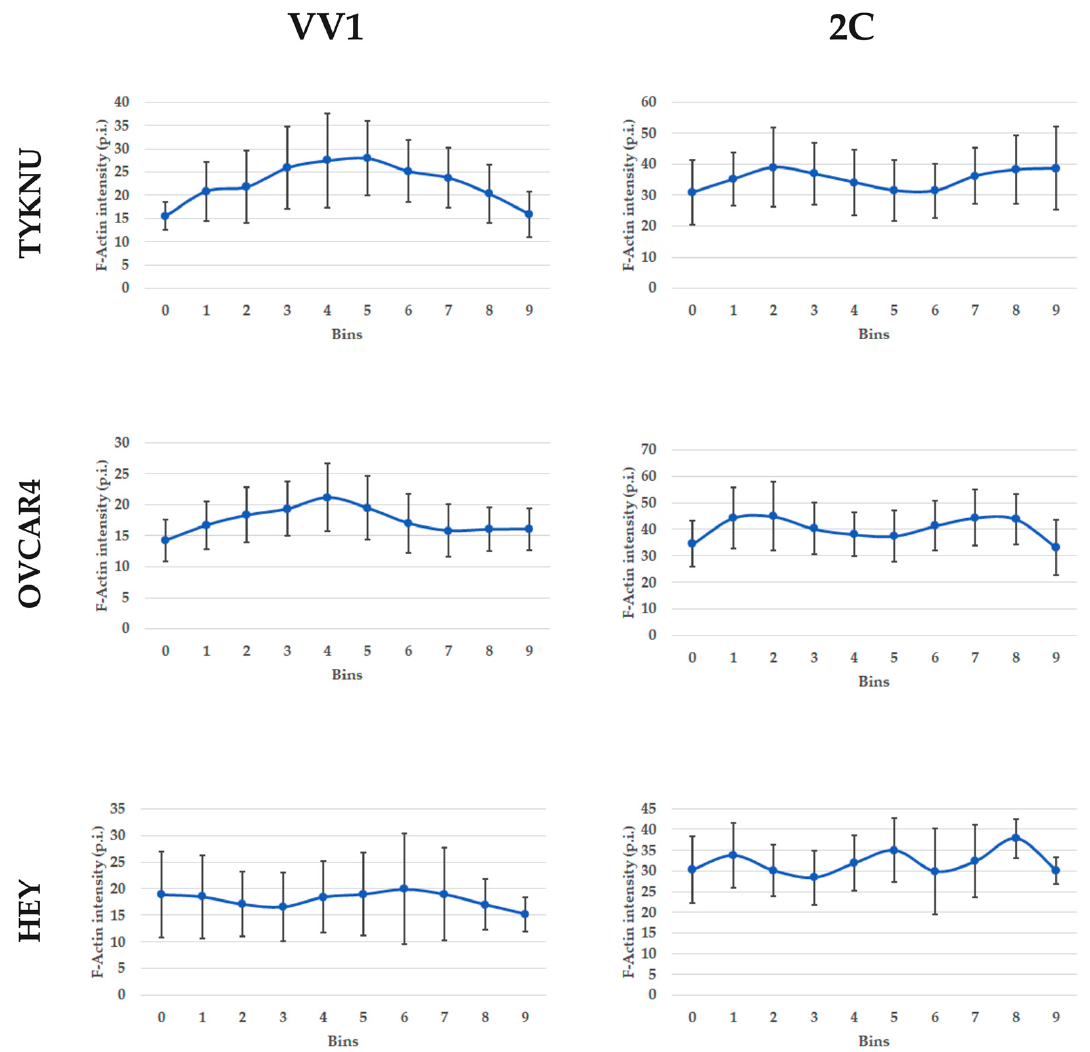
Figure 8. F-actin fluorescence intensity profile for cell lines treated with the inactive control drug VV1 or 2c. X-axis: cell centroid crossline divided into 10 equal sections (bins). The three most external bins (1–3 and 8–10) indicate the cell periphery while the inner ones (4–7) indicate the cell center. Y-axis: average F-actin fluorescence intensity for each bin expressed as mean pixel intensity. Points bars indicate the 95% confidence interval (CI).